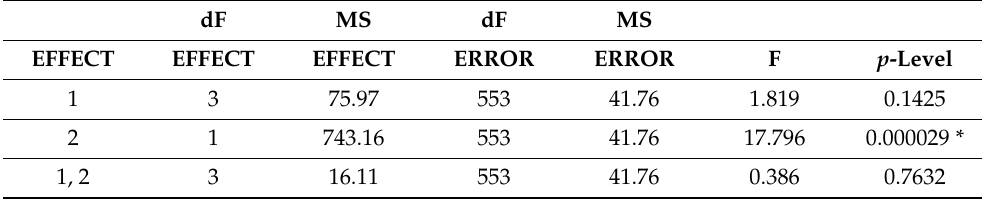
Table 3. Handwriting quality (BHK quality): General MANOVA. dF